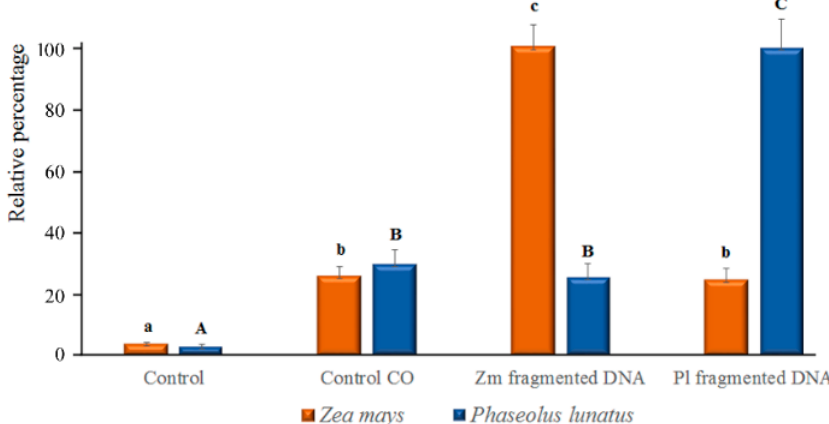
Figure 6. Relative percentage of the Ca 2+ release shown in confocal Figures 4 and 5. In both species, a significant ( p < 0.05) difference was found between controls and fragmented DNA only when esDNA was used. Error bars represent standard error ( n = 8–10). Different letters (small caps for maize and capital letters for Lima bean) indicate significant differences ( p < 0.05, Tukey–Kramer HSD) between treatments and controls.